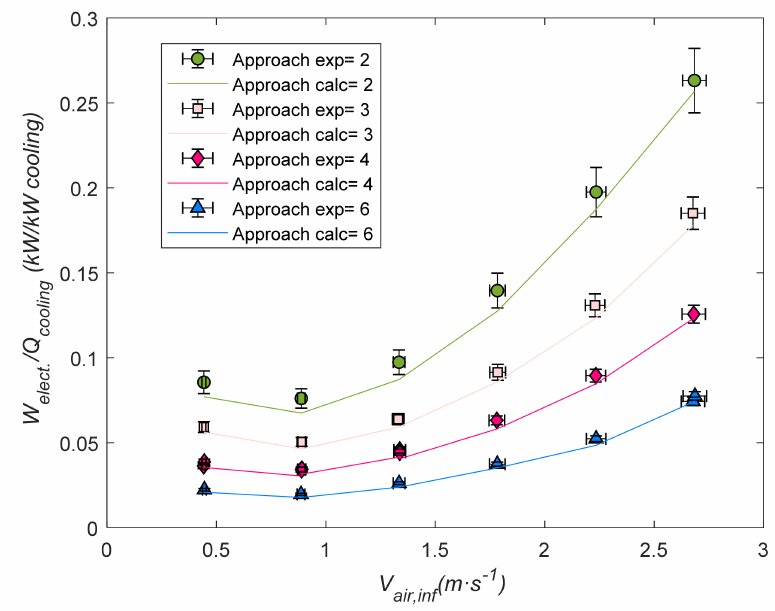
Figure 12. Experimental energy to cooling capacity ratio for different approach temperatures and air velocities. Data obtained at a constant water Reynolds number of 5000, and spray flow 80 kg · h − 1